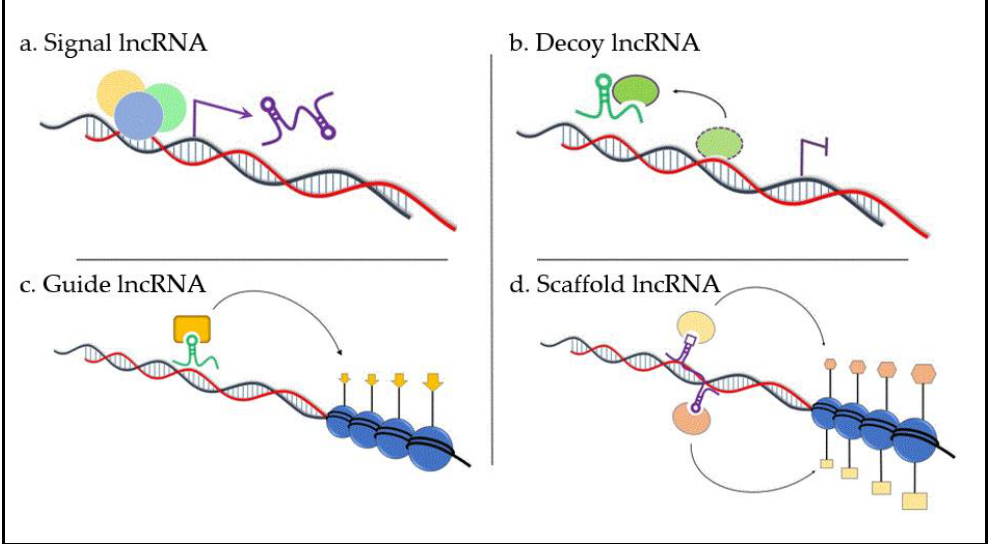
Figure 1. Four archetypes of long non-coding RNA (lncRNA) molecular mechanisms.